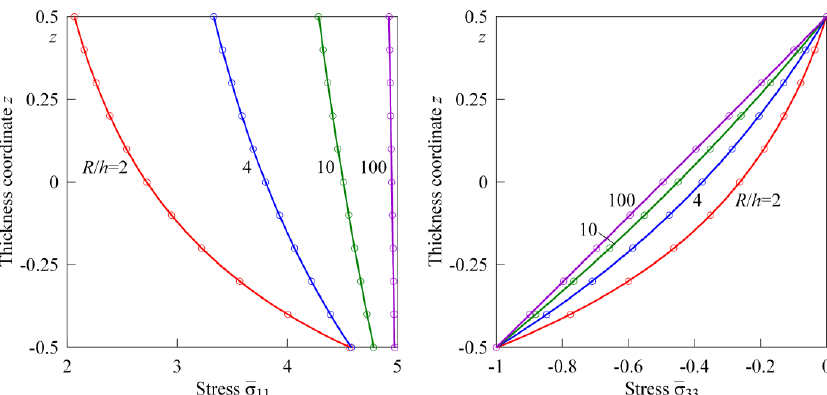
Figure 8: A part of the spherical shell modeled by regular 2 n × 1 meshes, where n = 1,2, . . . ,32.